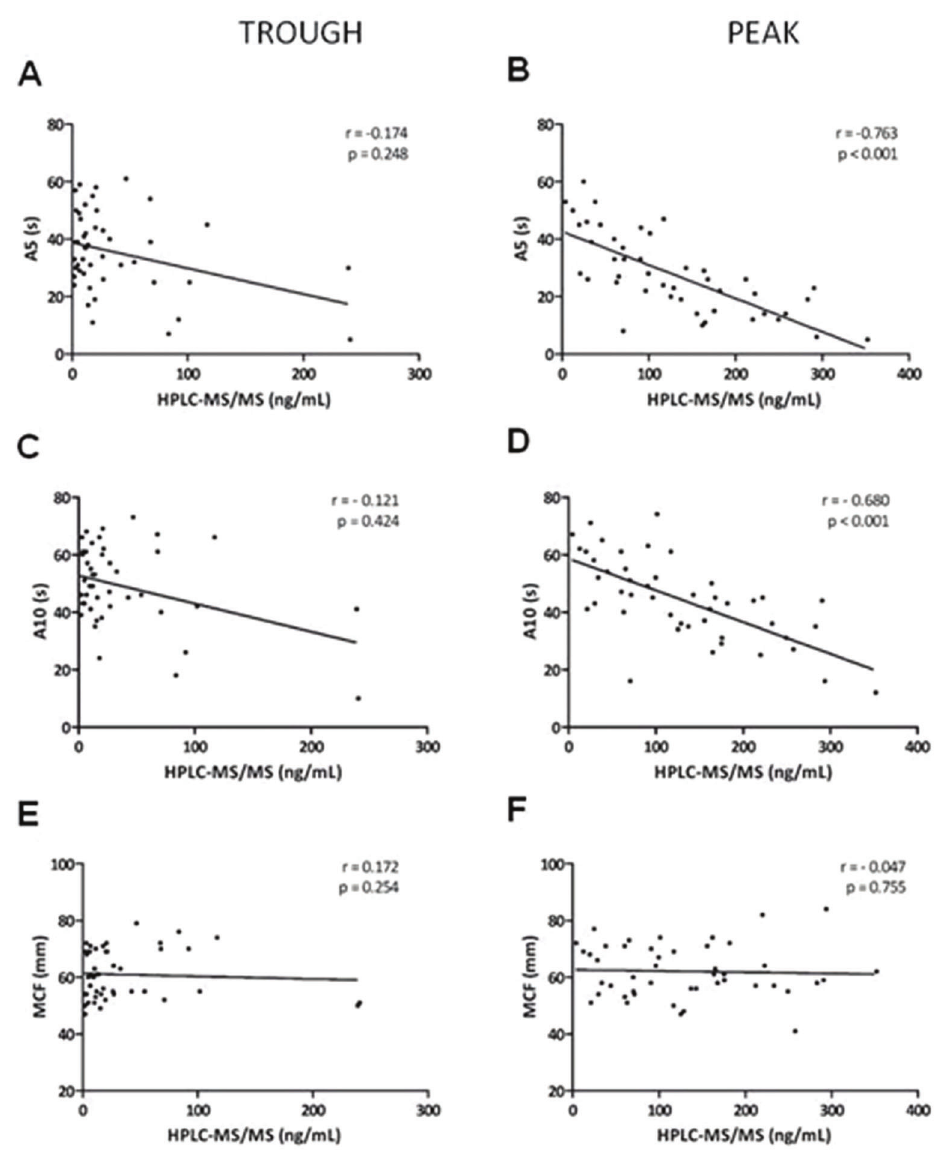
Figure 3. Correlation between high-performance liquid chromatography tandem mass spectrometry (HPLC-MS/MS) and thrombo- elastometry differentiating trough and peak for A5 ( A and B ), A10 ( C and D ), and maximum clot fi rmness (MCF) ( E and F )